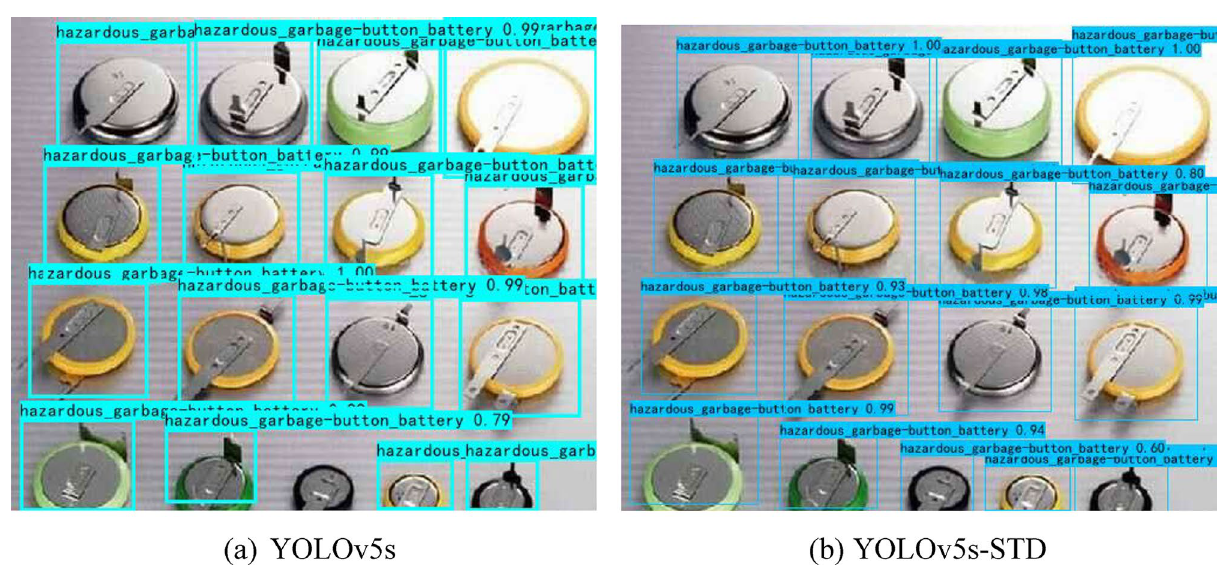
Figure 10. The actual detection effect of the network